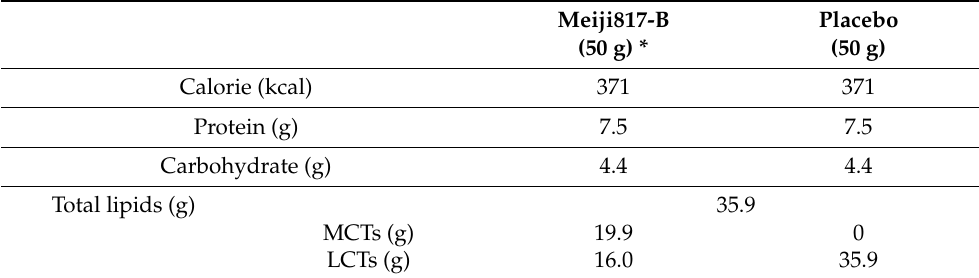
Table 2. The components of Meiji817-B and placebo